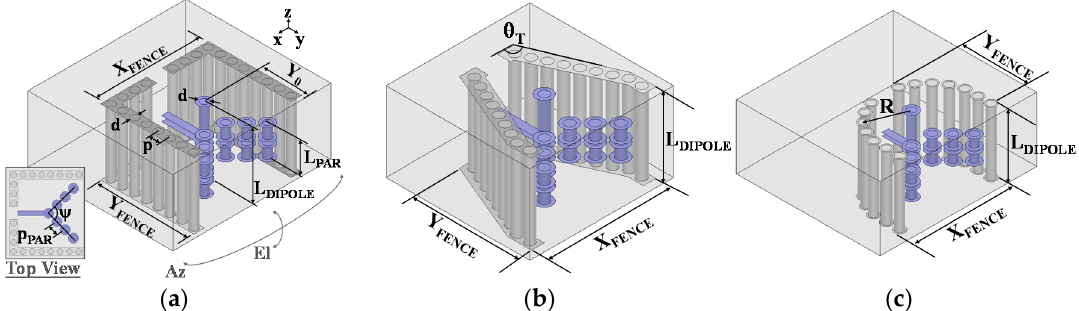
Figure 1. Electric dipole with di ff erent fence shapes implemented at the edge of Rogers RO5880 substrate. ( a ) Rectangular fence. ( b ) V-shaped fence. ( c ) U-shaped